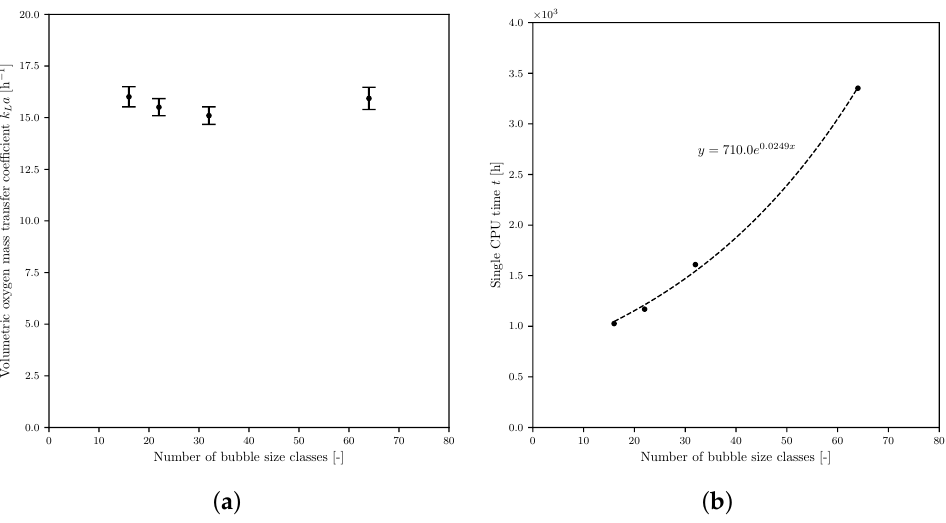
Figure 9. Results of the class method PBM simulations. ( a ) Influence of the number of bubble size classes on the k L a value; ( b ) relationship between the number of bubble size classes and CPU